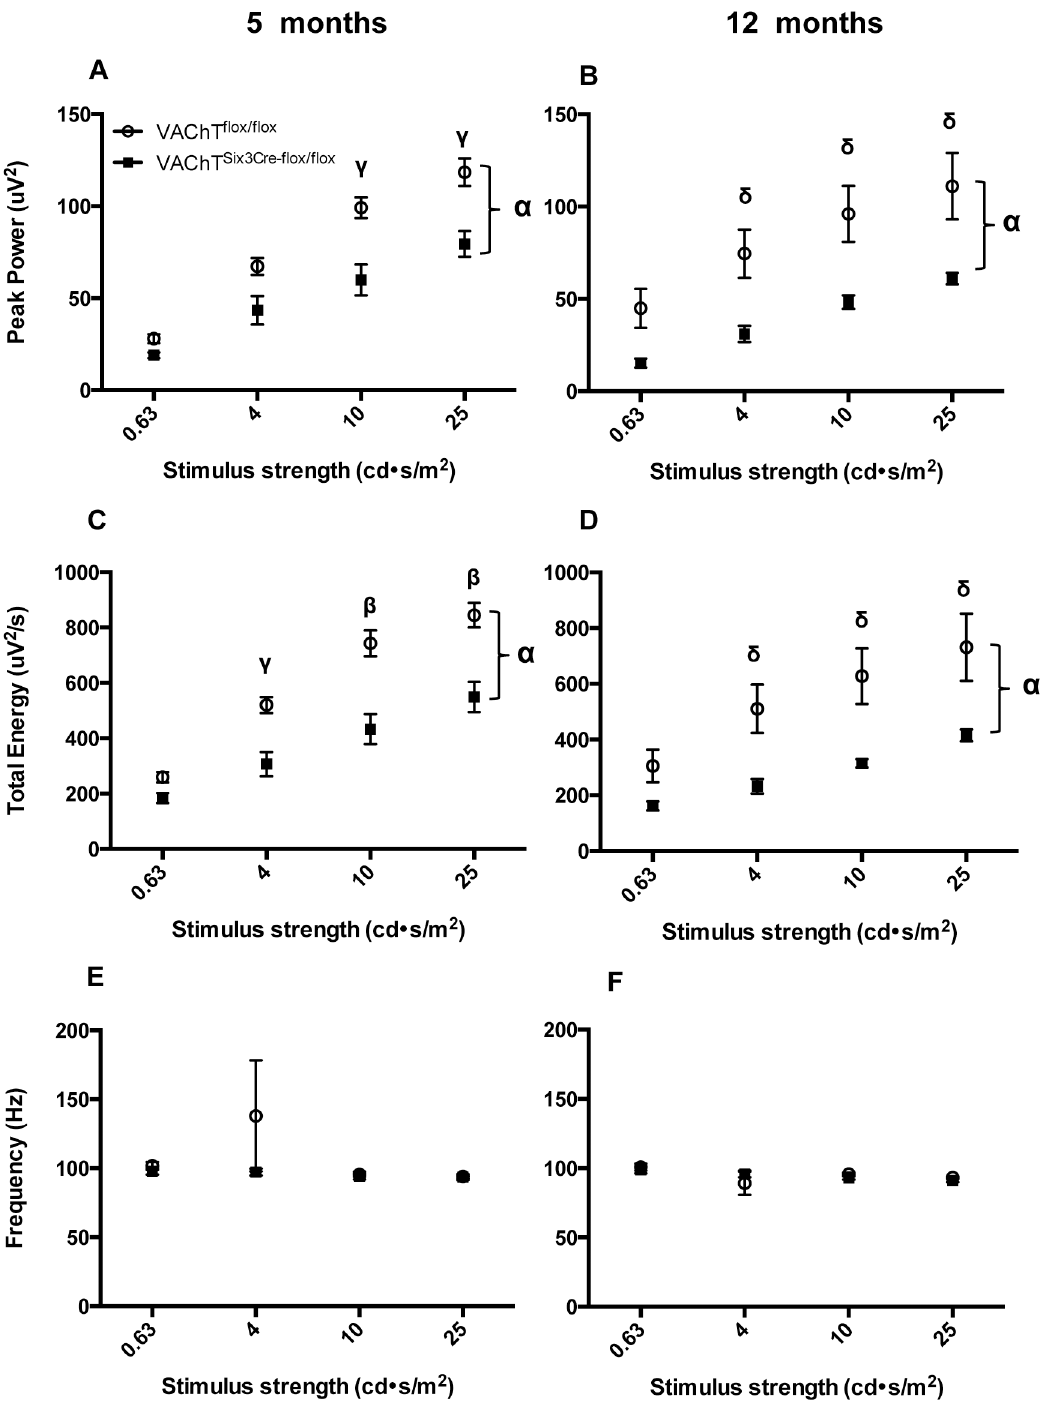
Fig 7. Assessment of oscillatory potential (OP) maximum power, total energy and frequency. A fast Fourier transformation was applied to OP data from the four highest stimulus strengths (0.25 – 25 cd+s/m 2 ) filtered with a bandpass of 65-300Hz to assess OP profiles in the frequency domain. Peak power is decreased in VAChT Six3-Cre-flox/flox retinas (open circles) relative to littermate controls (closed squares) at (A) 5 (n = 7 VAChT Six3-Cre-flox/flox and n = 12 littermate control) and (B) 12 months of age (n = 5 VAChT Six3-Cre-flox/flox and n = 5 littermate control). Total OP energy is also decreased in VAChT Six3-Cre-flox/flox retinas relative to littermate controls at both (C) 5 and (D) 12 months of age. Average OP frequency does not differ between VAChT Six3-Cre-flox/flox and littermate control mice at either (E) 5 or (F) 12 months of age. Values represent the mean ± SEM. δ , P < 0.05; γ , P < 0.01, β , P < 0.001, α , P < 0.0001 versus control